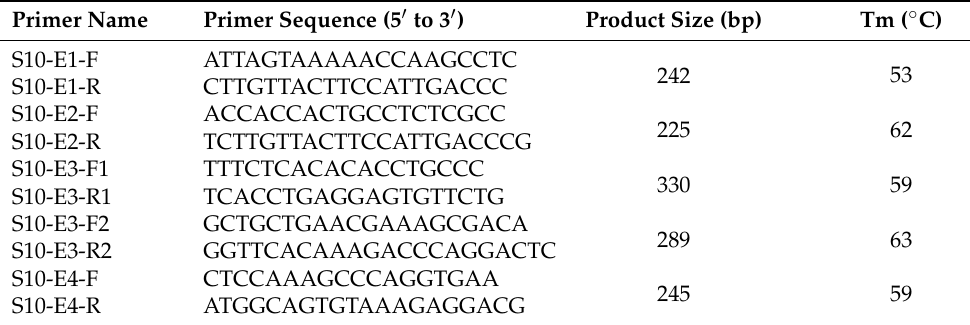
Table 1. Primers designed to amplify the SOX10 gene sequence.